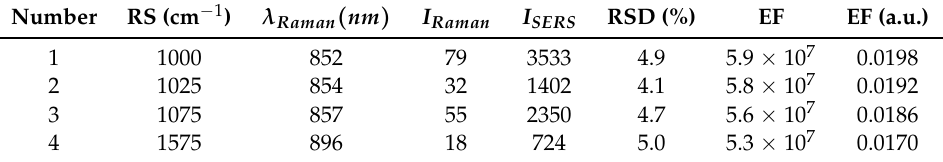
Table 1. For λ exc = 785 nm, and the four Raman shifts (RS) of thiophenol, λ Raman coinciding with RS, the intensities I Raman and I SERS , relative standard deviations (RSDs) coinciding with I SERS , EF obtained with Equation (1) and EF values (in arbitrary unit, see Equation (5)) calculated with the E 4 model are